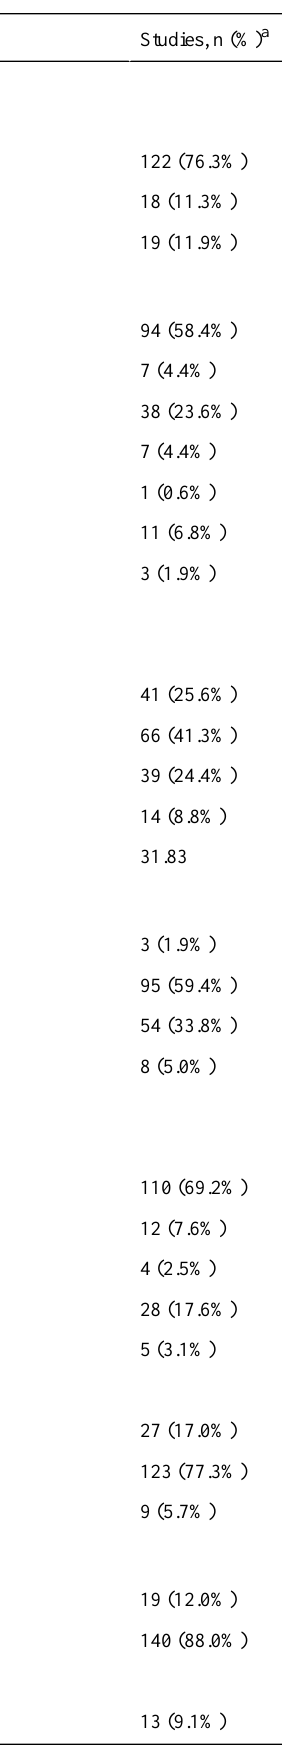
Table 1. Characteristics of the included studies